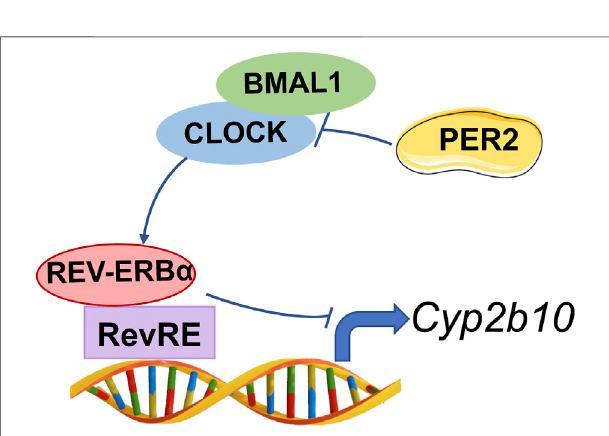
FIGURE 9| Schematic diagram illustrating themolecular mechanism for PER2 regulation of CYP2B10.